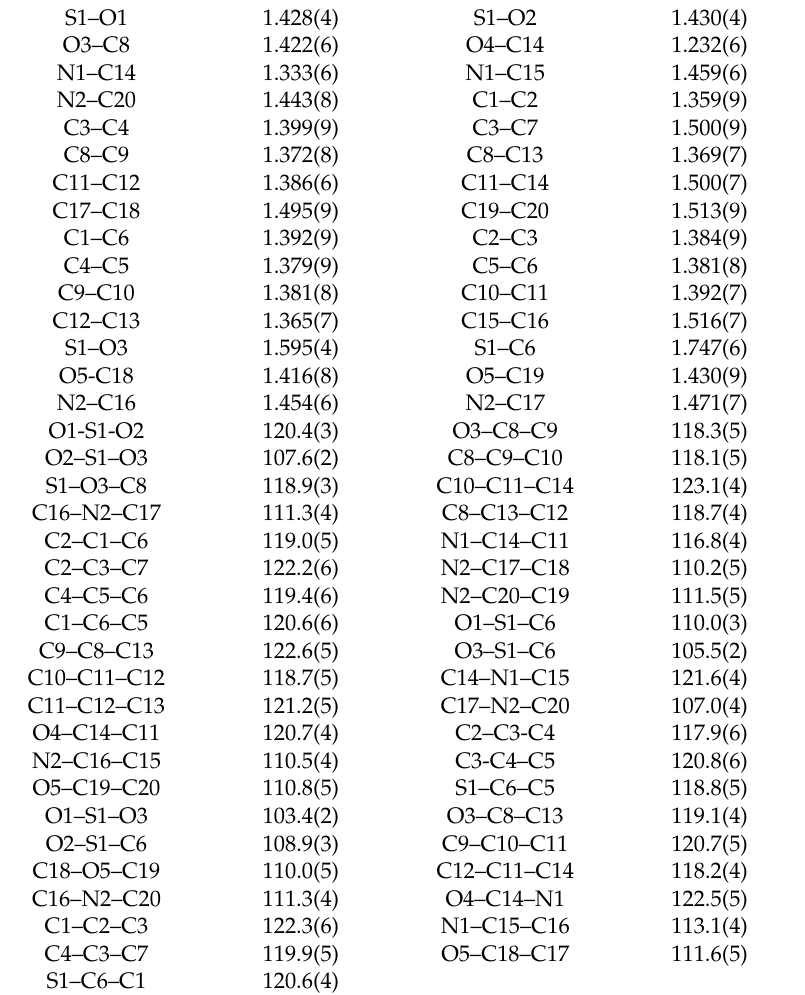
Figure 4. Atom numbering and thermal ellipsoids at a 30% probability level for 7a . Table 5. Bond lengths (Å) and angles ( ◦ ) for 7a